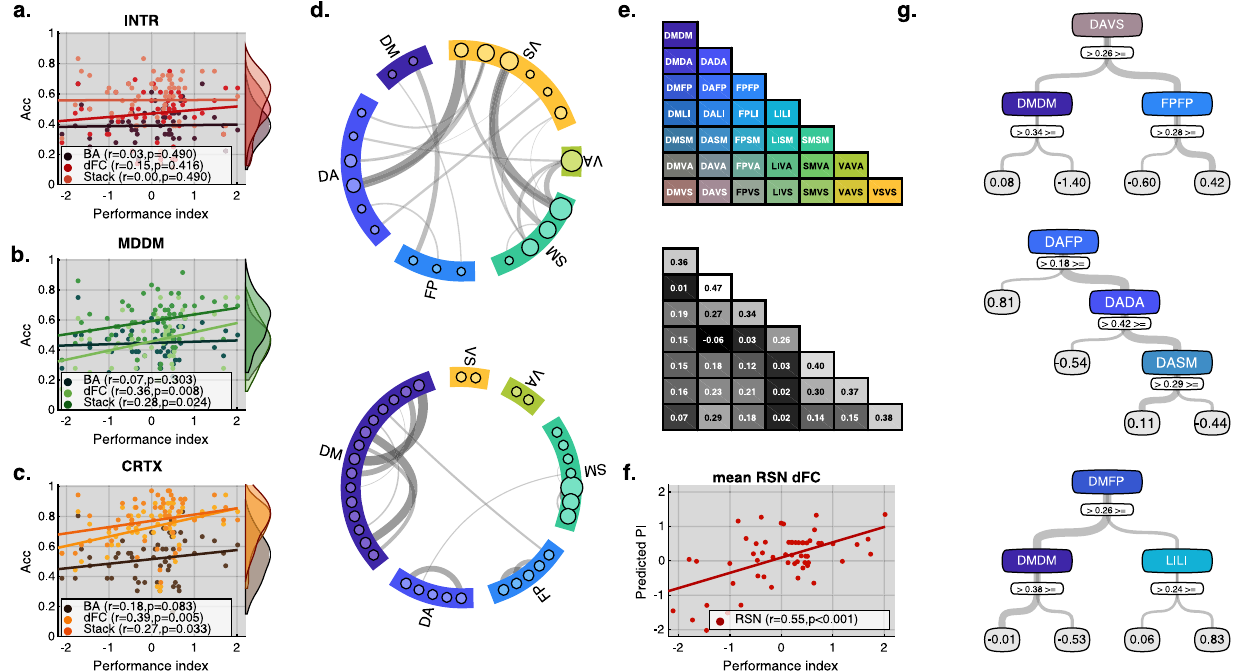
Fig. 6 Cortical connectivity in networks previously de fi ned by resting state analysis (RSN) 21 predicts individual task performance. a – c The following scatter plots test association between overall performance index (PI) across all tasks ( x -axis) and classi fi cation accuracy ( y -axis) using a right-tailed Pearson correlation coef fi cient test. All tests are FDR corrected. Individuals with higher scores express more accurately classi fi able task-evoked network states. Best classi fi cation was achieved by the stack models. The strongest correspondence to intelligence was produced by the connectivity (dFC) models. d Schema-ball plots showing top 0.1% of connections that were stable across 58 (i.e. one for each participant) leave-one-out sparse one-vs-all multi-class models. Top panel shows positive weights used to differentiate any one task from the other 11 and is dominated by connections that are between RSNs. Bottom panel shows the negative weights used to identify features that are similar for most tasks and is dominated by connections that are within RSN. e Top panel diagonal shows the seven within RSN labels (i.e. Default mode = DM, Dorsal attention = DA, Frontoparietal = FP, Limbic = LI, Somatomotor = SM, Ventral attention = VA and Visual = VS). The lower triangle shows the 21 unique between RSN combinations. Colours correspond to those in d and g . Bottom panel shows the mean dFC for each of the RSN combinations averaged across the 12 tasks. Using cross-validated leave-one-out grid search we identi fi ed the optimal ensemble boosted structure with respect to the maximal number of branch node splits and the maximum number of trees to train (converged on 3 and 3). We then quanti fi ed by 58 independent boosted regression trees. f Scatter plot showing the predicted performance index ( y -axis) is signi fi cantly association ( p = 3.59e − 6) with the actual performance index ( x -axis) as quanti fi ed by 58 independent ensemble trees using a right-tailed Pearson correlation coef fi cient test. g Boosted regression trees trained on the entire sample (i.e. not cross-validated) identi fi ed the most important combinations of features for explaining individual differences in performance. Increased connectivity between dorsal attention (DA) and visual (VS) systems was strongly associated with better performance. In contrast, increased connectivity within the default mode (DM) network combined with decreased connectivity between either DA to VS or DM to frontoparietal (FP) was associated with lower performance. Source data are provided as a Source Data fi